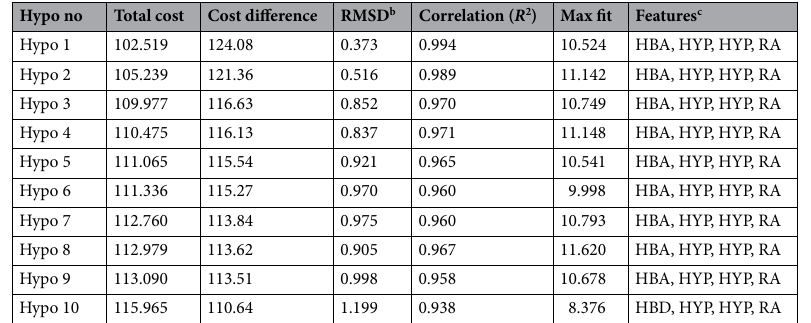
Table 1. Statistical results of ten pharmacophore hypotheses generated by HypoGen. a Cost difference, the difference between the null cost and the total cost. The null cost of ten scored hypotheses is 226.602, the fixed cost value is 98.657, and the configuration cost is 16.80. All costs are represented in bit units. b RMSD: deviation of the log (estimated activities) from the log (experimental activities) normalized by the log (Uncertainties). c HBA: Hydrogen Bond Acceptor, HYP: Hydrophobic, RA: Ring Aromatic.